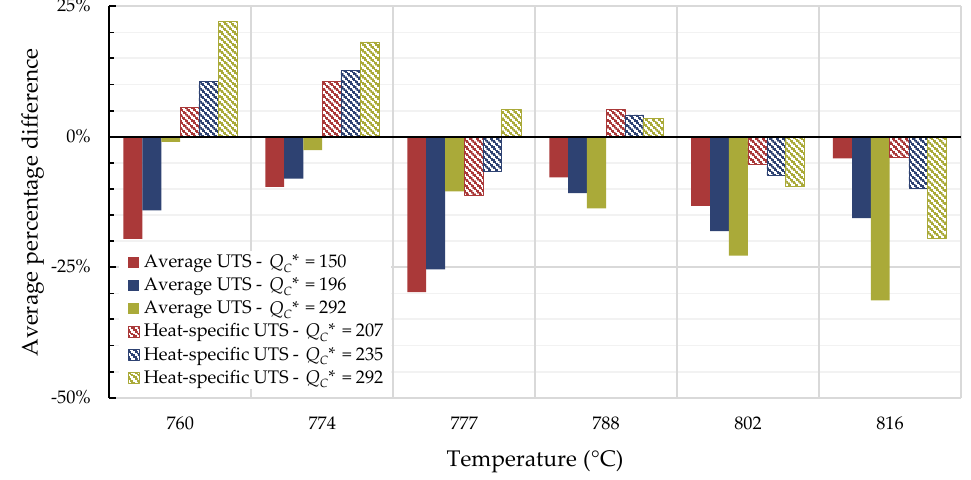
Figure 10. Average percentage difference at each temperature for Nimonic 105 using data with times to rupture less than 10,000 h to calculate 𝑄 𝐶∗ (kJ/mol).